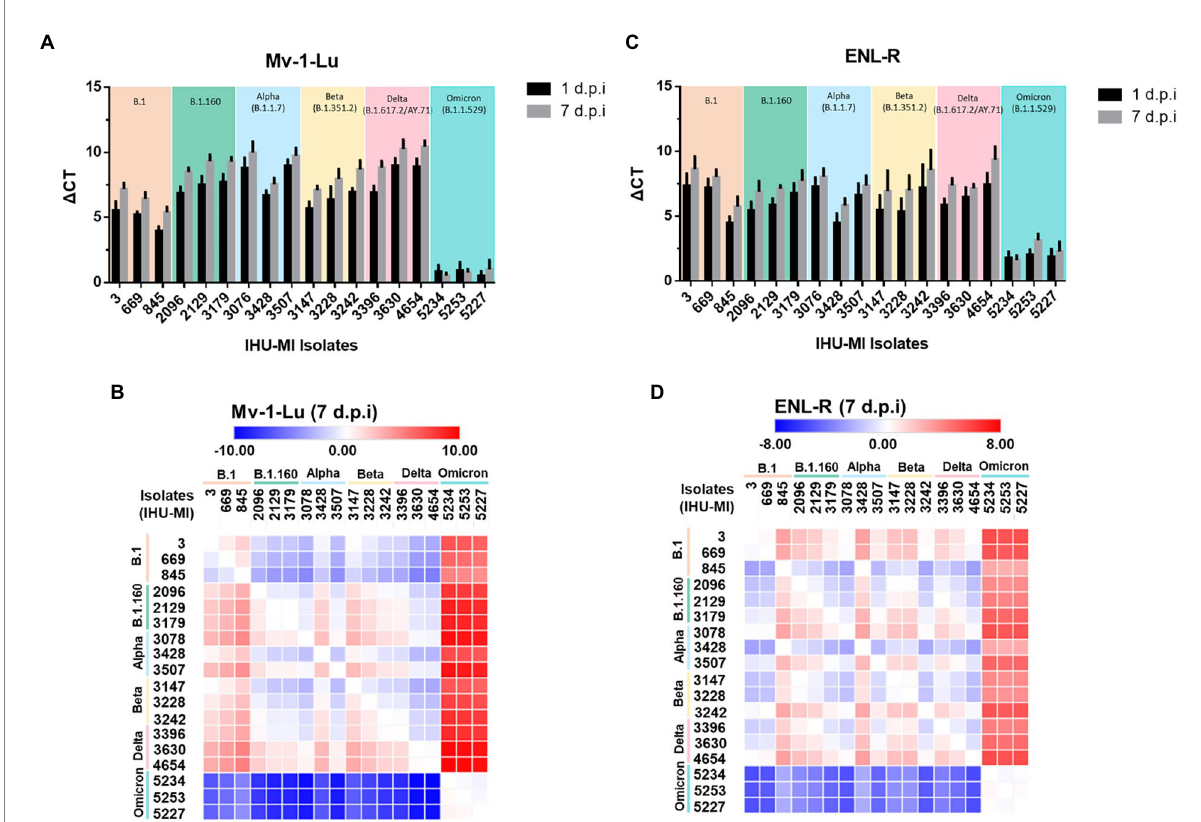
FIGURE 1 SARS-CoV-2 viral replication in mink cells. Replication rate of 18 isolates of SARS-CoV2 belonging to six different lineages in two cell lines derived from mink lungs. The viruses have been grouped based on the PANGO classification. The replication rate is expressed in Δ Ct (cycle threshold) between time 0 and 1 days postinfection (black) and between time 0 and day 7 post-infection (gray); (A) Replication rate on the Mv-1-Lu cell line; (B) Heatmap comparing SARS-CoV-2 variant replication on Mv-1-Lu mink cells 7 days post infection; (C) Replication rate on the ENL-R cell line; (D) Heatmap for SARS-CoV-2 variant replication on ENL-R mink cells 7 days post